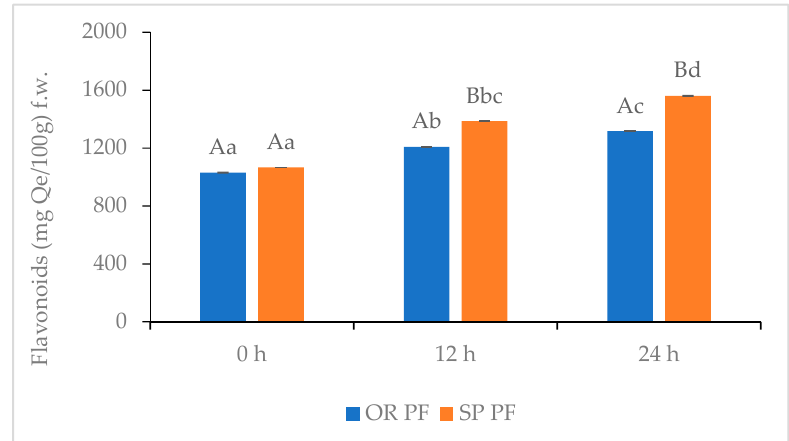
Figure 9. Total flavonoids of gluten free muffins. Small letters in common indicate no significant differences between OR and SP samples withdrawn at different moments; Big different letters indicate significant differences between SP and OR samples withdrawn at the same moments.